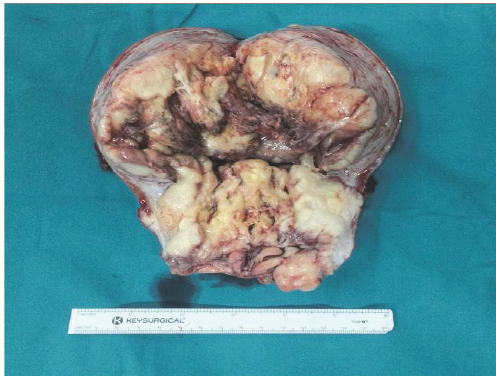
Figure 2: Gross examination of uterus reveals an enlarged uterus 13x13x7 cm with an intracavitary polypoid mass occupying the entire endometrial cavity and endocervical